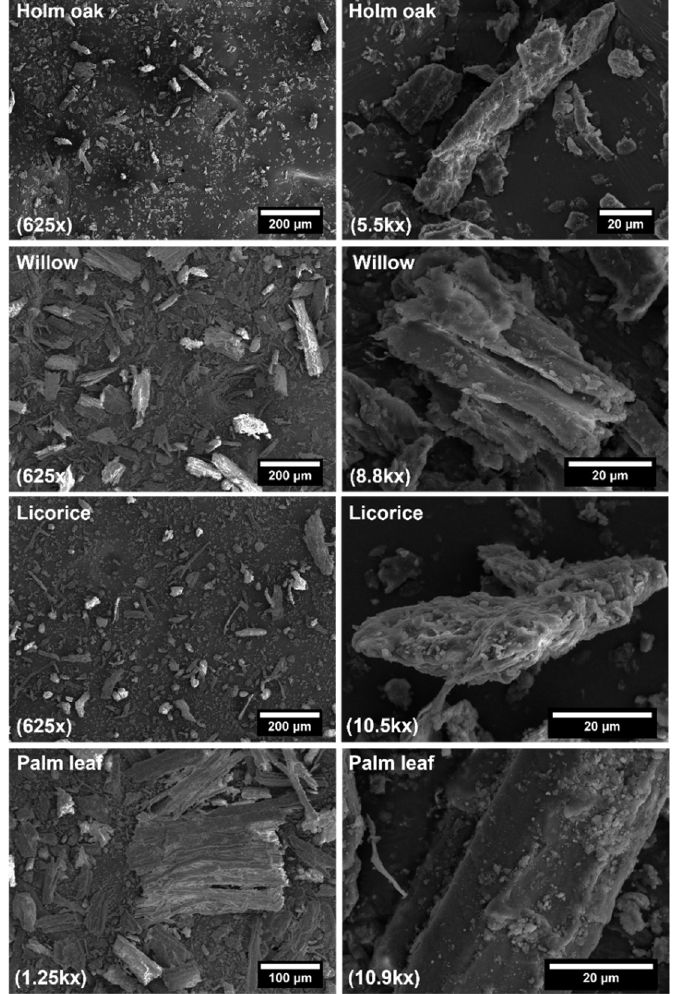
Figure 3. SEM micrographs of ground fillers (in parenthesis the corresponding